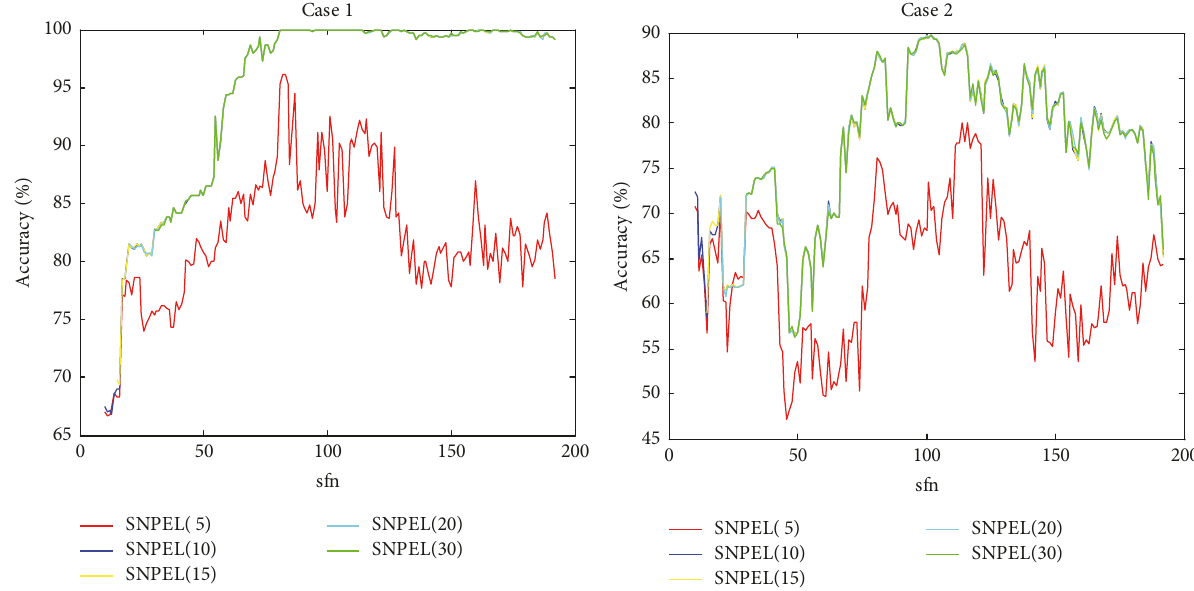
Figure 33: The diagnosis results obtained by OFS-FSASD-SNPEL-SVM with different number of dimension sizes for SNPEL. The SNPEL (5) represents that the number of dimension sizes is 5.